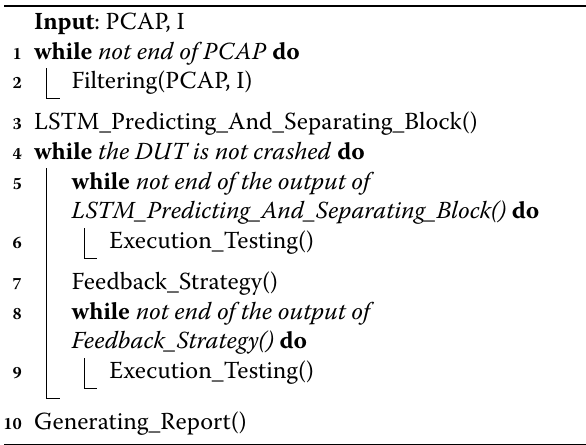
Algorithm 1: Fuzzing with ICPFuzzer